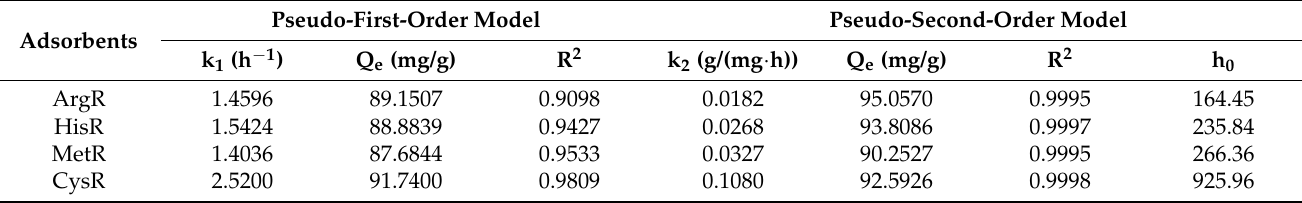
Table 1. Kinetic parameters obtained from kinetic models.